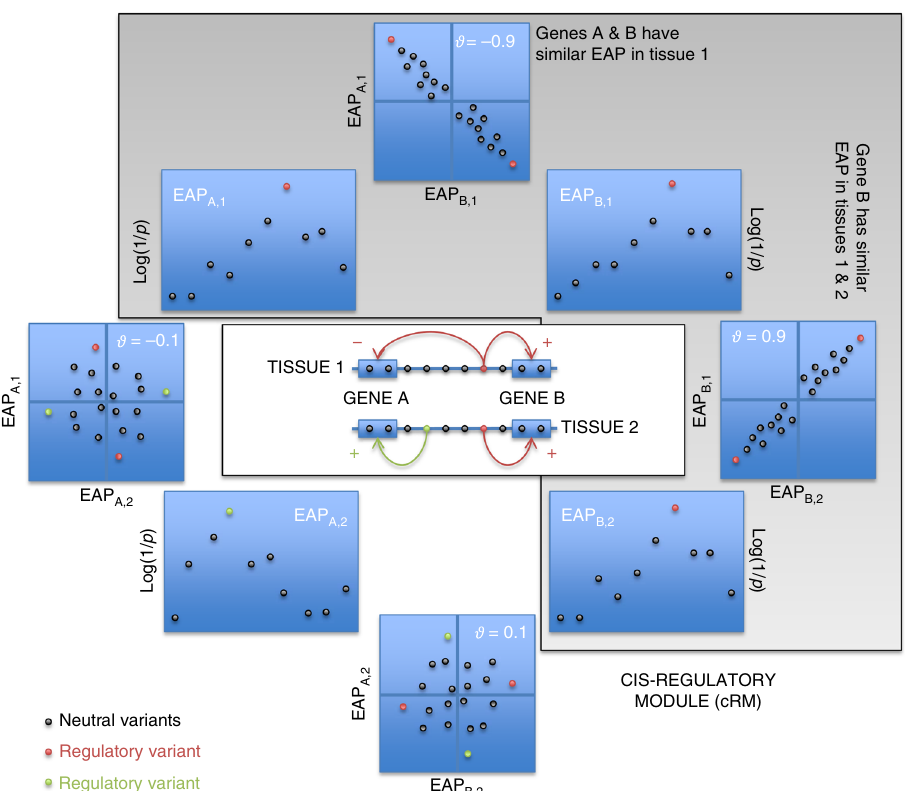
Fig. 1 cis -Regulatory Module (cRM). A cis -eQTL affecting gene A in tissue 1 reveals itself by an “ eQTL Association Pattern ” (EAP A,1 ), i.e., the pattern of – log ( p ) values for variants in the region. Multiple EAP can be observed in a given chromosome region, affecting one or more genes in one or more cell types. EAP that are driven by the same underlying variants are expected to be similar, while EAP driven by distinct variants (for instance, the green and red regulatory variants in the fi gure) are not. Based on the measure of similarity introduced in this work, ϑ , we cluster the EAP in cRM. For EAP in the same module, ϑ can be positive or negative, indicating that the variants have the same sign of effect (increasing or decreasing expression) for the